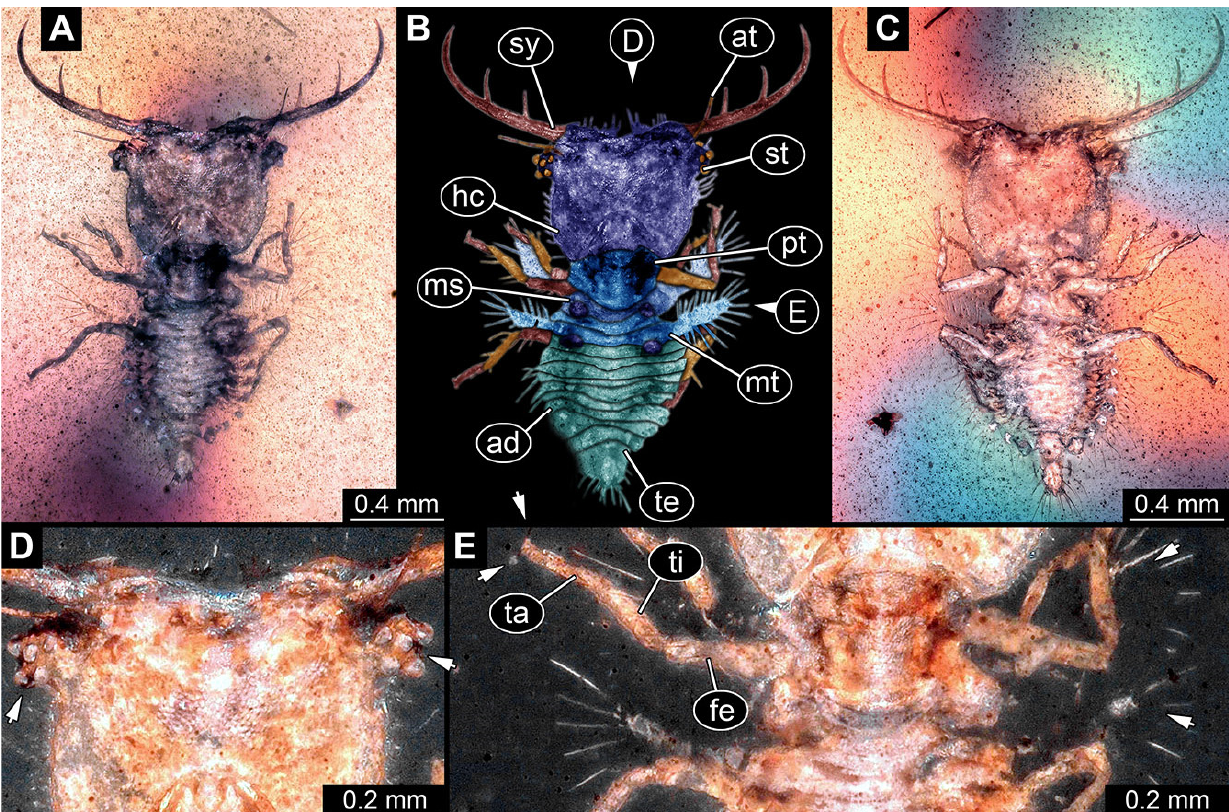
Figure 10. Fossil owllion larva, specimen 3222 (BUB 3062), Cretaceous Kachin amber, Myanmar. ( A ) Overview, dorsal. ( B ) Color-marked version of ( A ). ( C ) Overview, ventral. ( D ) Close-up on head capsule with fields of stemmata (arrows). ( E ) Close-up on anterior trunk with locomotory appendages with claws (left arrows) and dorsal processes (right arrows). Abbreviations: ad = abdomen; at = antenna; fe = femur; hc = head capsule; ms = mesothorax; mt = metathorax; pt = prothorax; st = stemmata; sy = stylet; ta = tarsus; te = trunk end; ti = tibia.